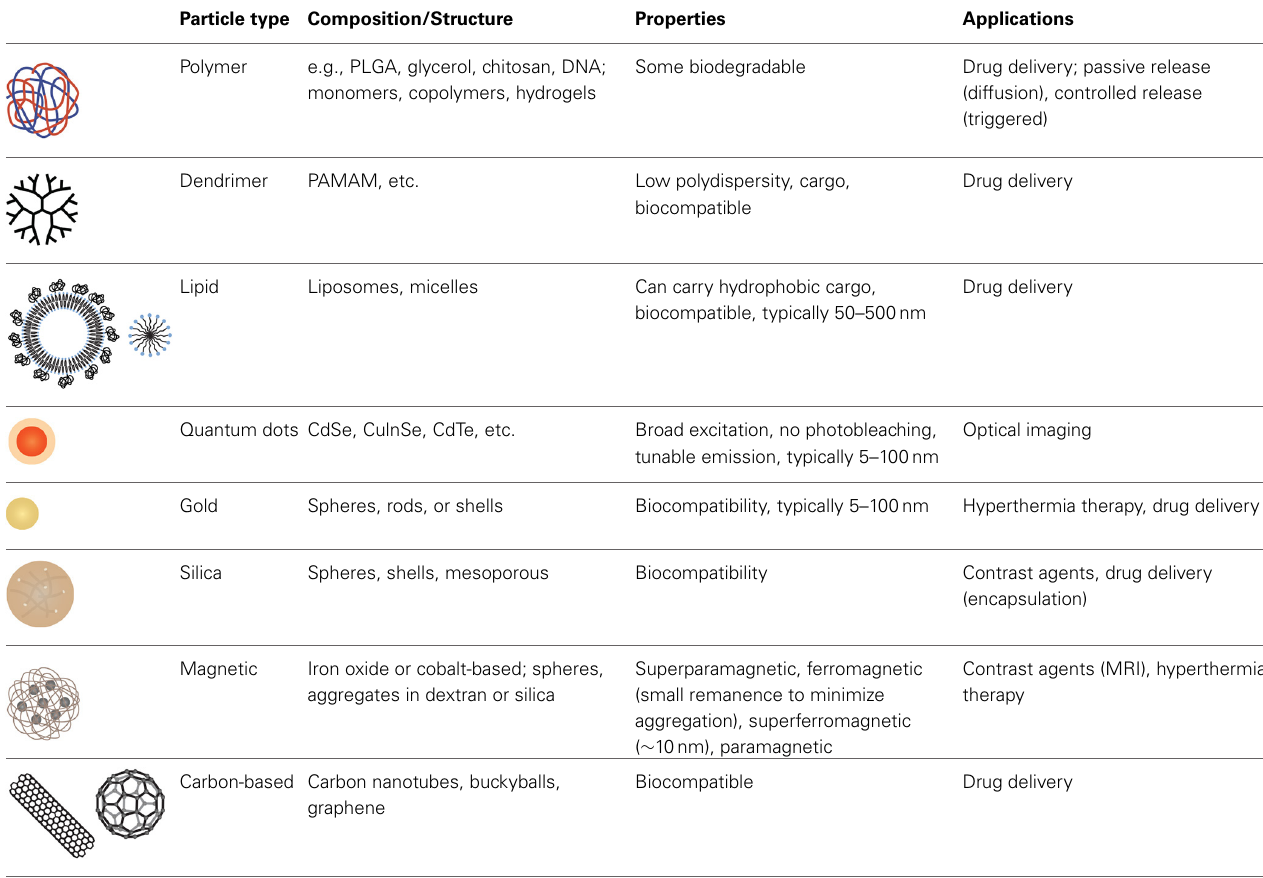
Table 3 | Summary of nanoparticle platforms for